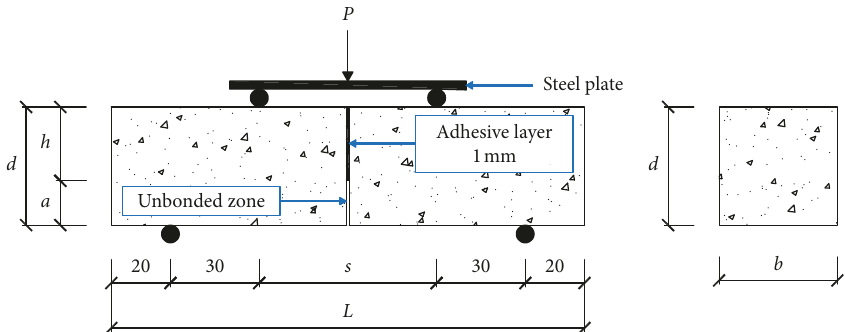
Figure 2: Schematic sketch of the sandwiched four-point bending specimen (all units in mm).